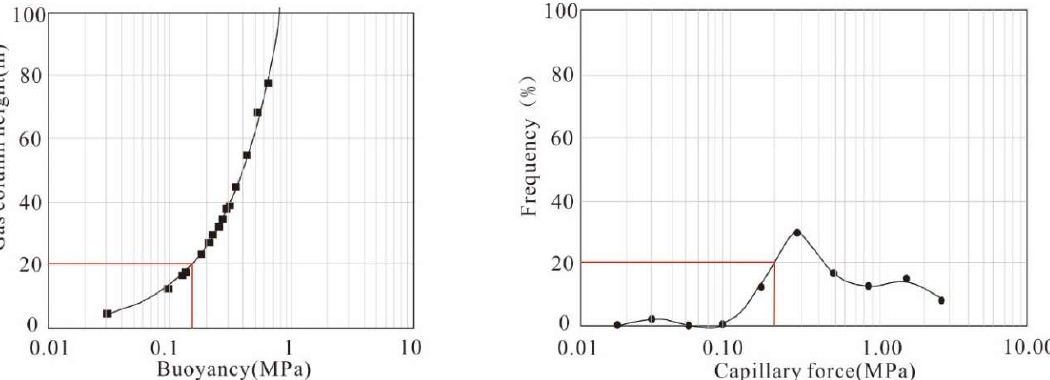
Figure 11. Frequency of capillary force and buoyancy produced by gas column height in Sulige gas field.